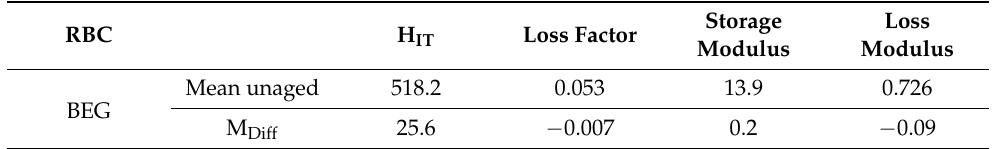
Table 4. Contrast results (K-Matrix): comparison of aged vs. unaged groups for the measured DMA parameters. The contrast estimate (M Diff ) is given for all significant comparisons ( p <